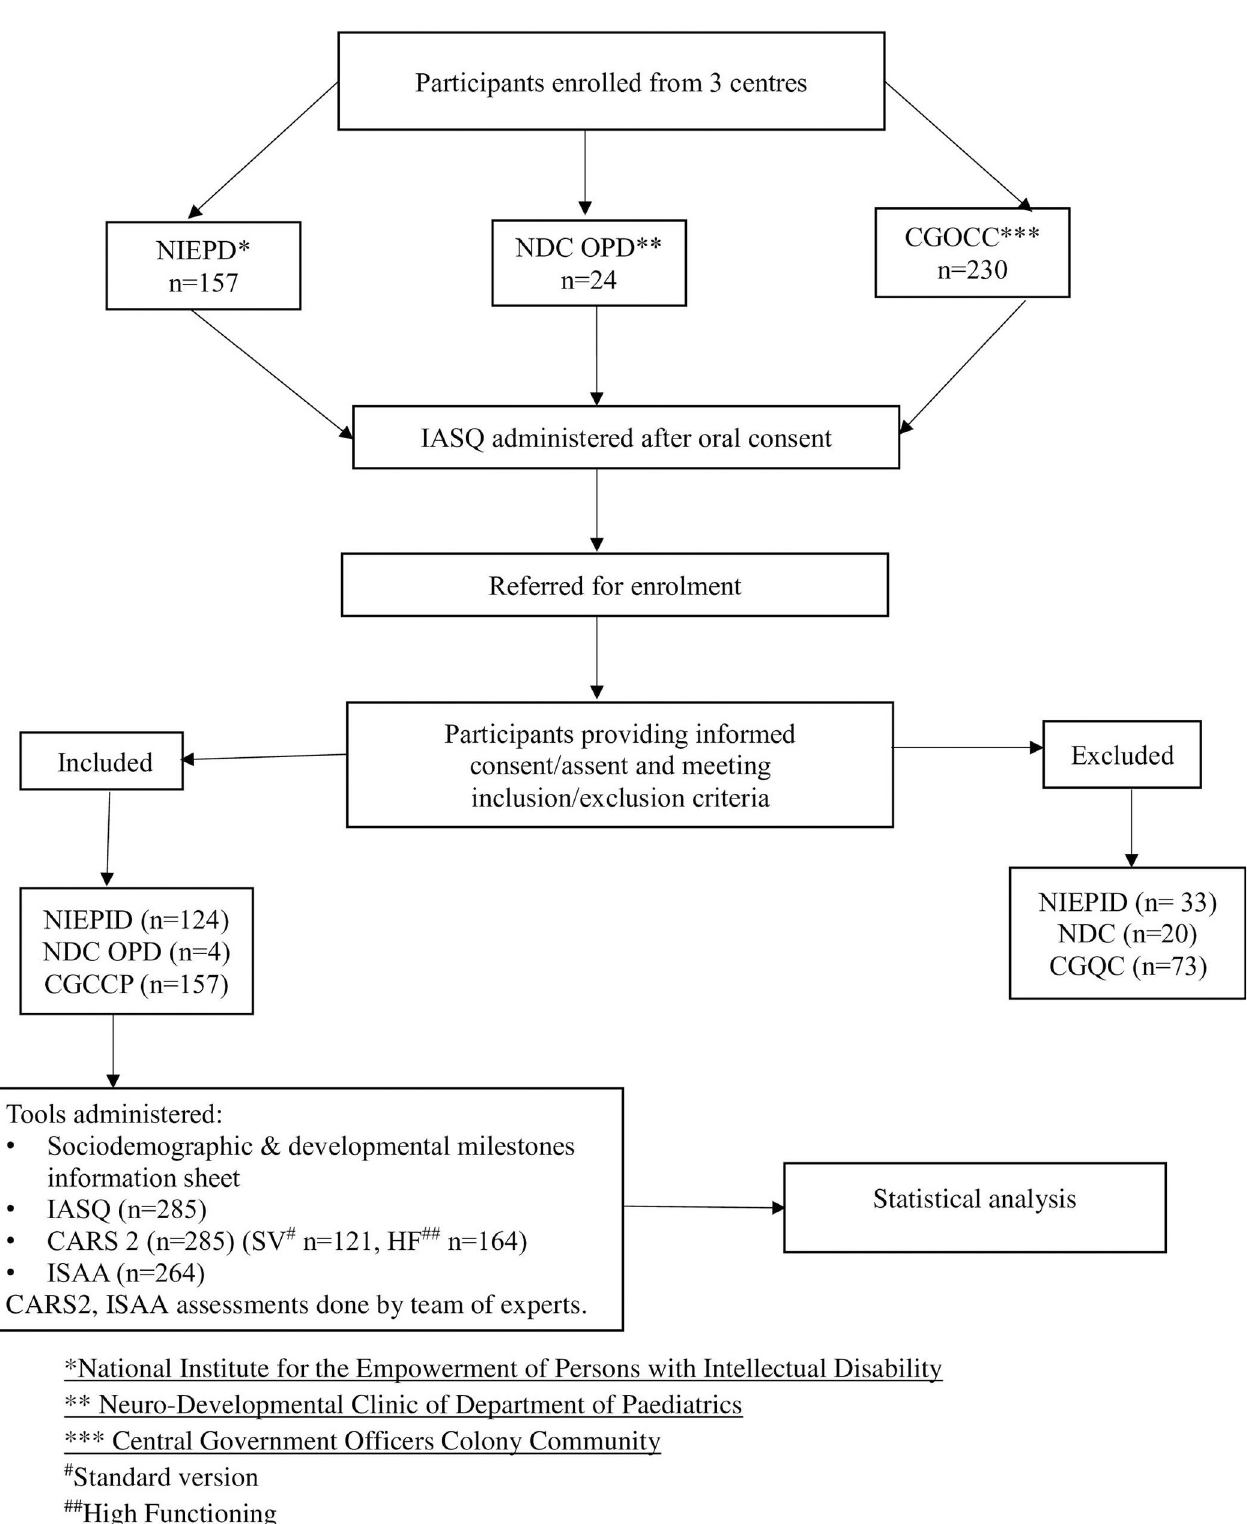
Fig 1. Recruitment chart of the participants.